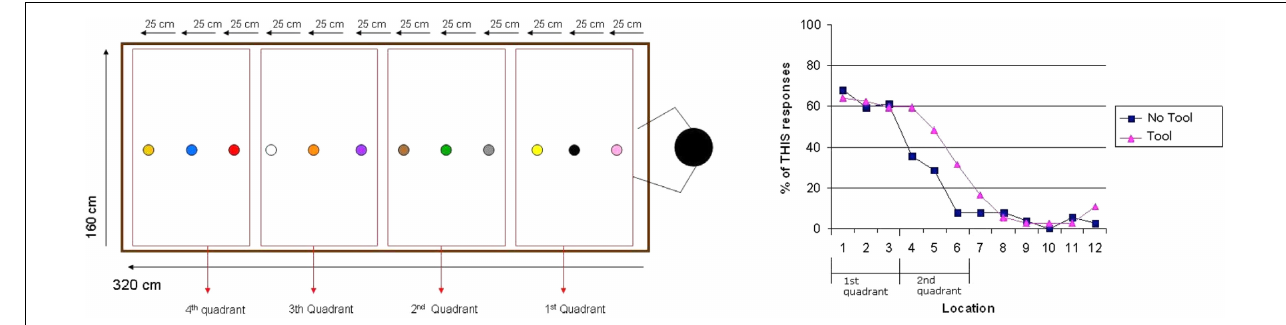
FIGURE 3 | Experimental set-up used by Coventry et al. (2008) (left panel) and associated results (right